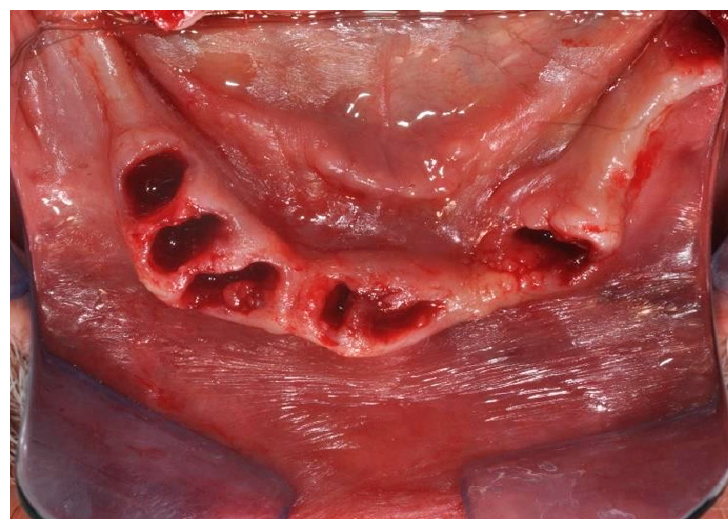
Figure 4. Surgical site after excision of compromised elements.